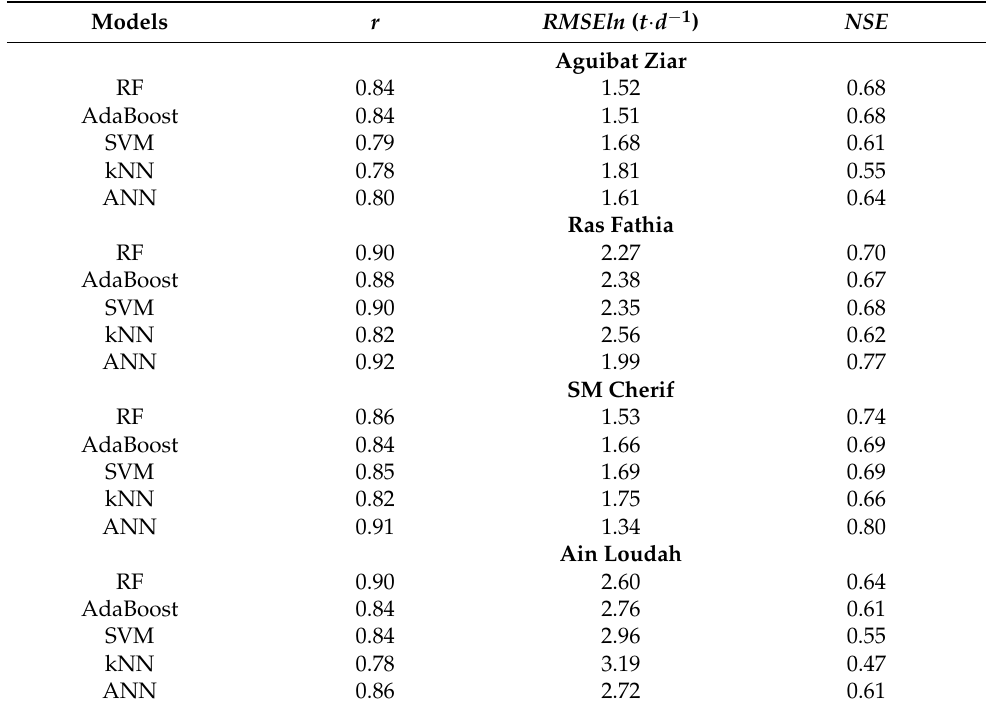
Table 6. Machine learning model performances during the validation